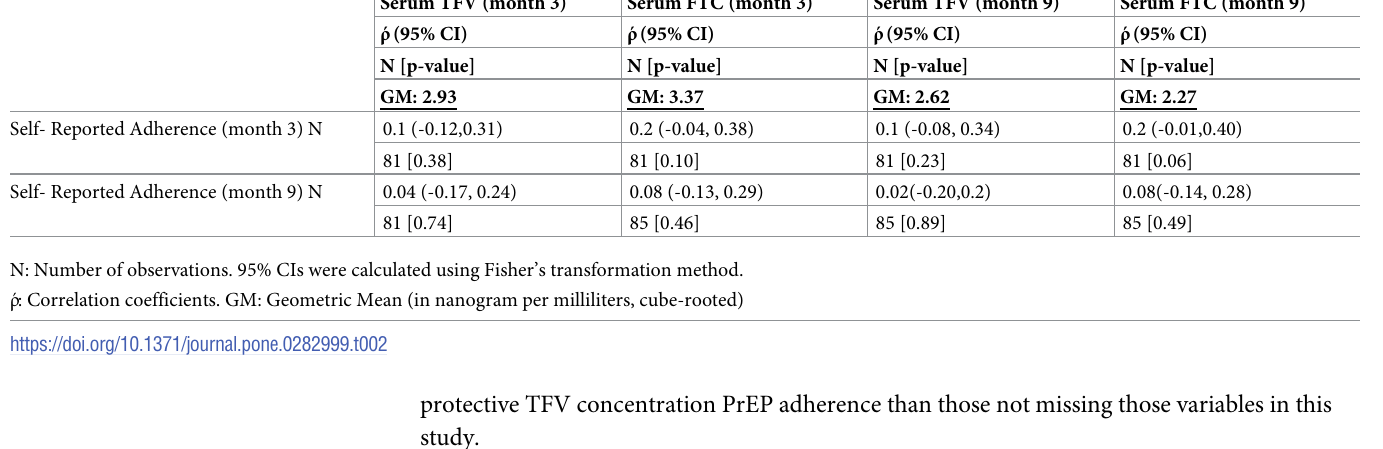
Table 2. Spearman correlation coefficient of quantification of TFV-FTC and self-reported adherence measures. Spearman correlation coefficients of quantification of TFV-FTC [ng/ml, cube-rooted] and self-reported adherence measures [ranked poor, good and very good].